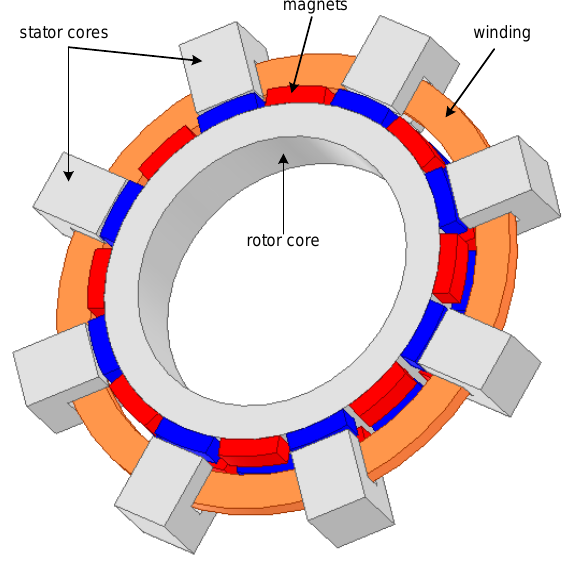
Figure 1. General view of the TFM machine segment .